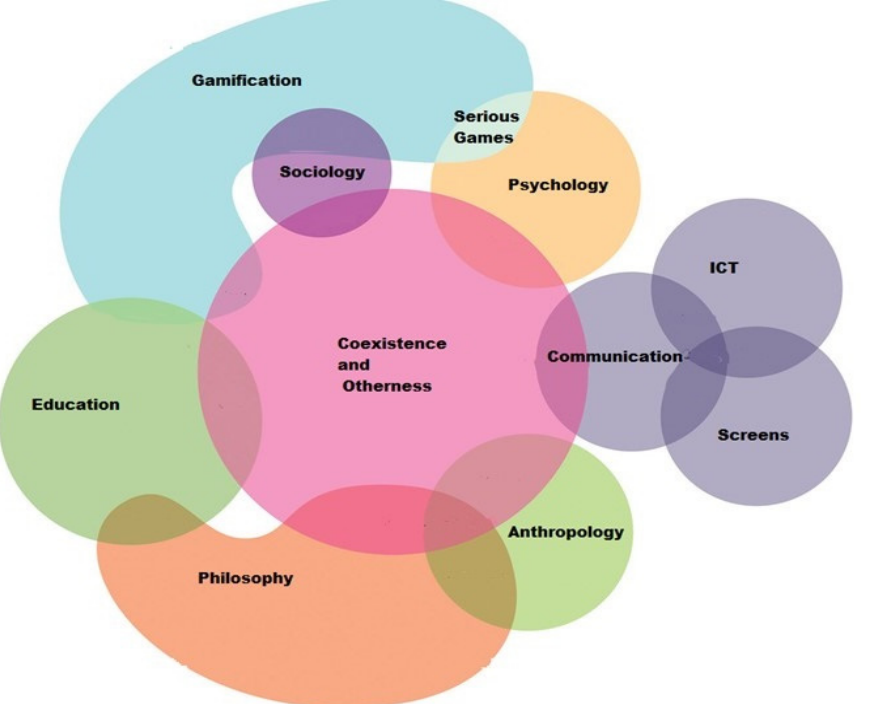
Figure 11. Venn diagram—Disciplines. Source: Self-generated.